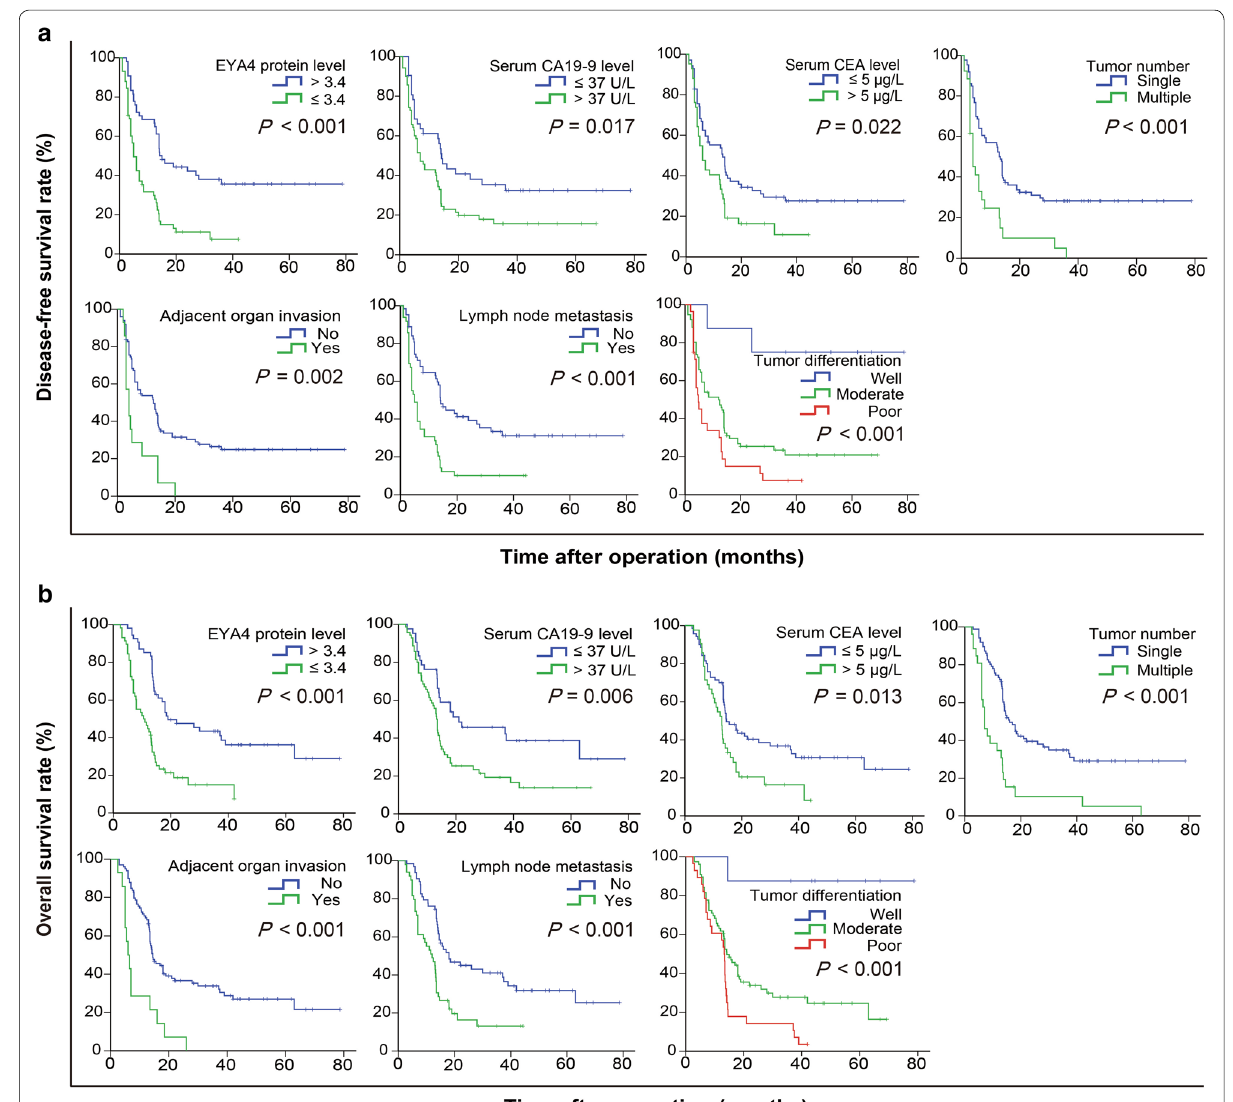
Fig. 2 Disease‑free survival (DFS) and overall survival (OS) curves of 112 ICC patients. a DFS curves of the 112 ICC patients show that patients with lower EYA4 protein levels, serum carbohydrate antigen 19‑9 (CA19‑9) level >37 U/L, serum CEA level >5 µg/L, multiple tumors, adjacent organ invasion, lymph node metastasis, and poor differentiation had worse DFS (all P < 0.05). b OS curves of the 112 ICC patients show that patients with lower EYA4 protein levels, serum CA19‑9 level >37 U/L, serum CEA level >5 µg/L, multiple tumors, adjacent organ invasion, lymph node metastasis, and poor differentiation had worse OS (all P <